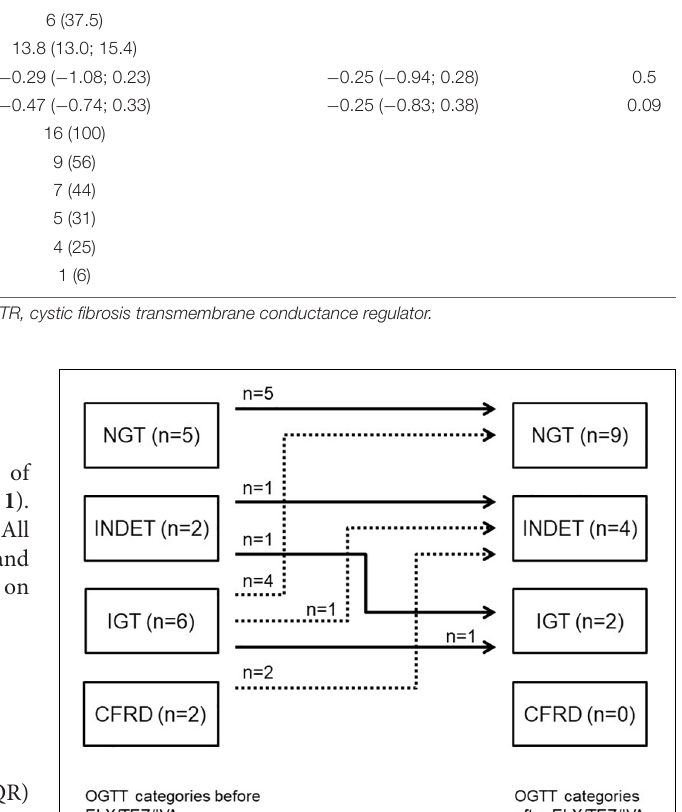
TABLE 1 | Demographic data of study population. Before ELX/TEZ/IVA therapy Under ELX/TEZ/IVA therapy P -value